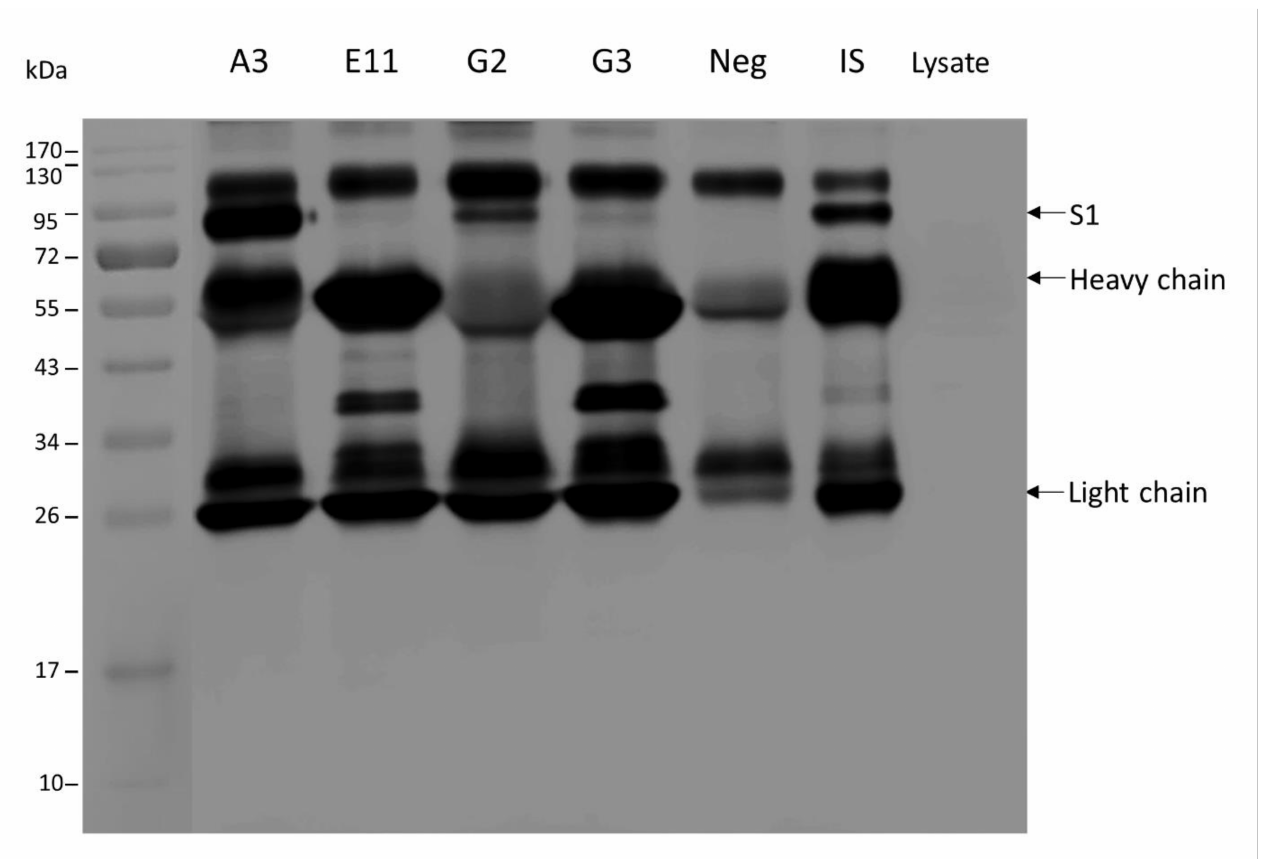
Figure 4. Binding of mAbs to native S1 protein. Combined co-immunoprecipitation and Western blotting was conducted to determine the binding activity of mAbs to native spike protein of PEDV. Ten micrograms of mAbs of individual hybridoma clones were mixed with lysate of PEDV infected cells. The mAb-Ag complexes were pull-down by using goat antimouse Ig sensitized-protein G. The pull-down content was then subjected to Western blotting by probing the SDS-PAGE-separated components with mouse immune serum against the PEDV rS1 (IS). The mAbA3, mAbG2, and mAbG3 could bind to the native S1 protein contained in the PEDV infected cell lysate and were pull-down together as demonstrated, i.e., the presence of the S1 band (~90 kDa, upper arrow) and the bands of heavy chains (~50–70 kDa, middle arrow) and light chains (~25 kDa, lower arrow) of the mAbs in Western blot analysis. Neg, reaction without mAb; IS, reaction added with mouse immune serum to PEDV rS1; Lysate, reaction containing PEDV infected cell lysate alone without any